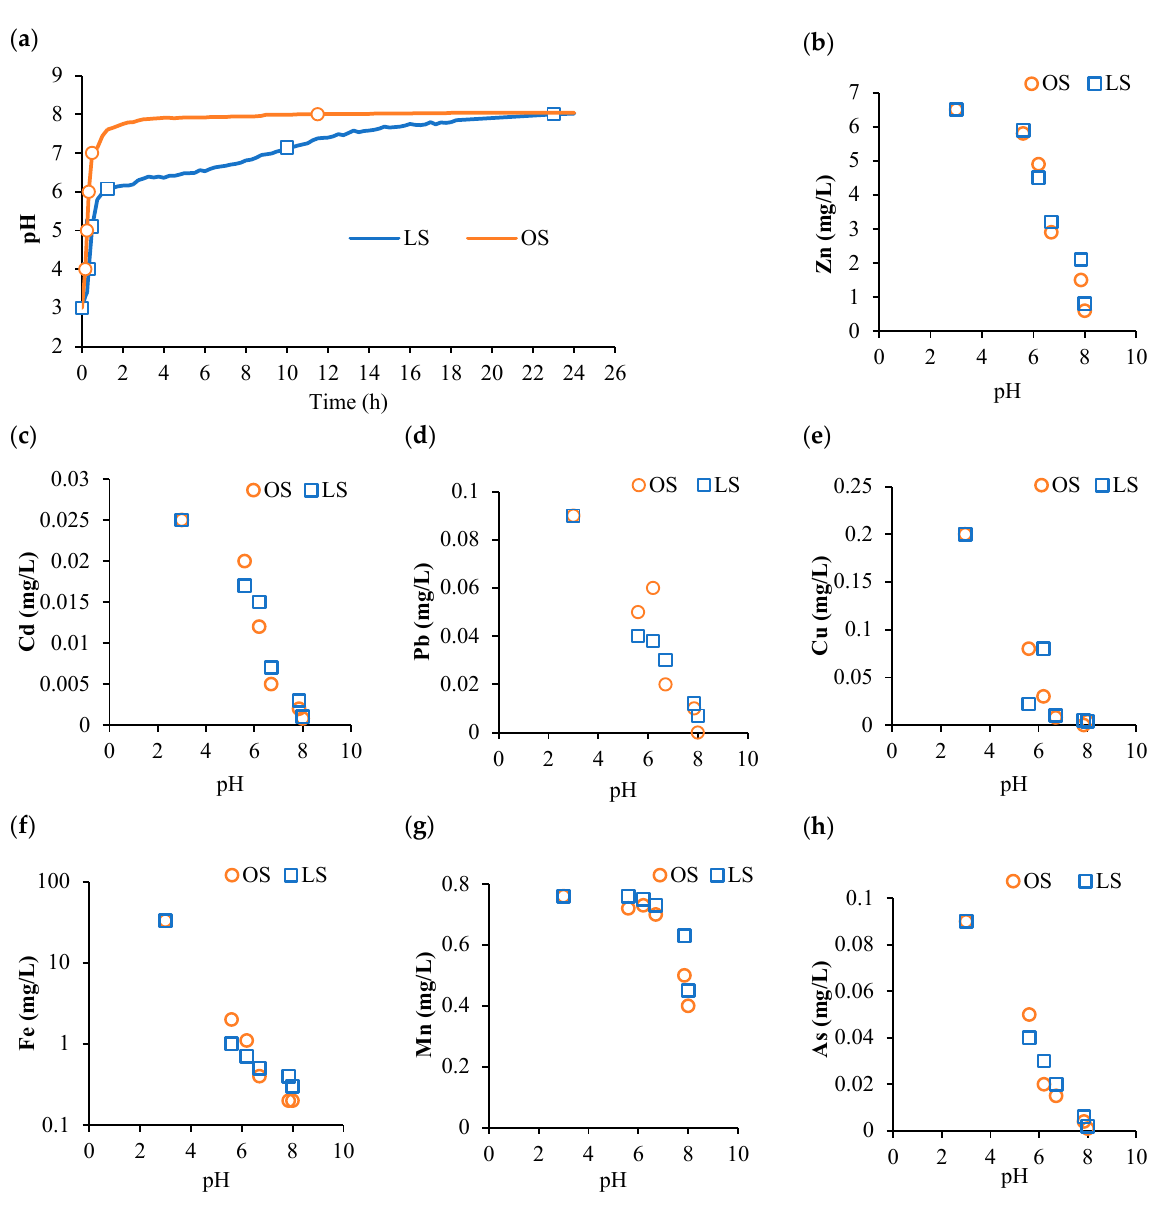
Figure 2. pH changes in AMD with oyster shells (OSs) and limestone (LS) for 24 h and relation between pH and metal concentrations: pH ( a ), Zn ( b ), Cd ( c ), Pb ( d ), Cu ( e ), Mn ( g ), Fe ( f ), and As ( h ).